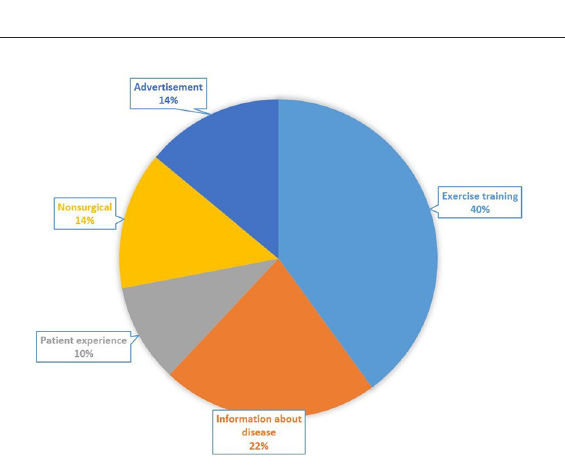
FIGURE3 Categorical distribution of the videos based on content.